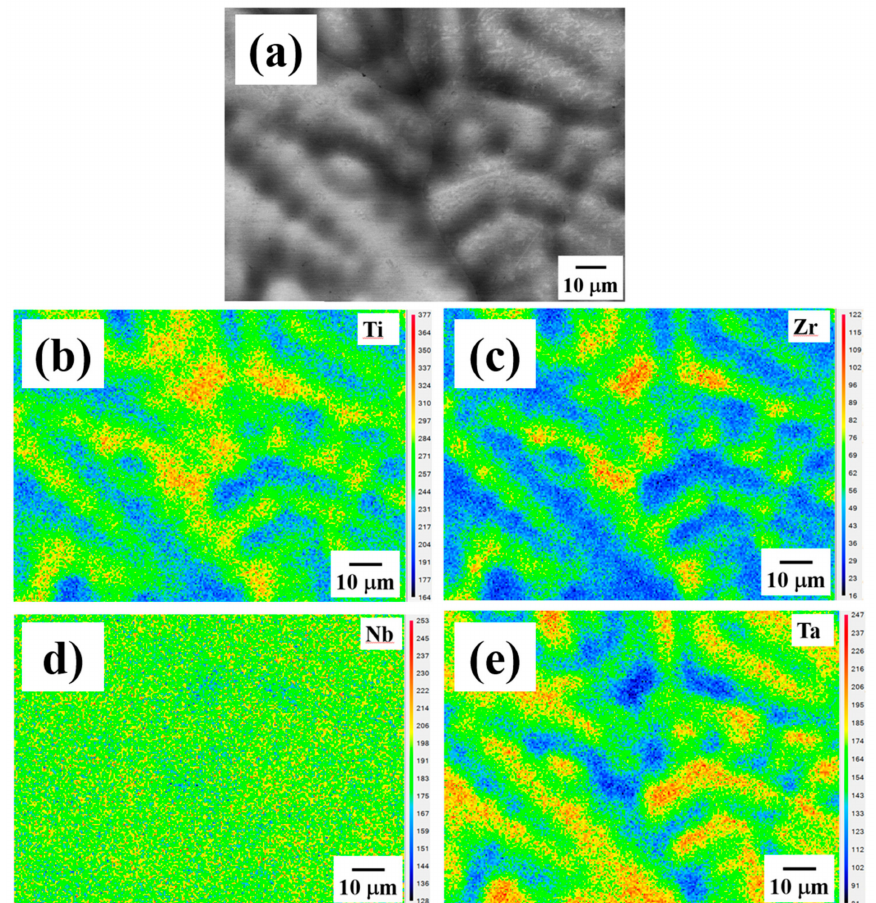
Figure 2. ( a ) The scanning electron microscope (SEM) back-scattered image (BEI) of the as-cast Ti 25 Zr 25 Nb 25 Ta 25 high-entropy alloy (HEA), and the corresponding composition mapping for ( b ) Ti, ( c ) Zr, ( d ) Nb, and ( e ) Ta. Note that the Nb mapping does not really expose the dendrites (DRs) and inter-dendrites (IDs) clearly. This may be attributed to the fact that the L α X-ray energy of element Nb (~2.169 eV) is slightly larger than the M absorption edge energy of element Ta (~1.804 eV). Therefore, in the dendrite regions, the L α X-ray energy of element Nb would be significantly absorbed, resulting in an underestimated amount of the element